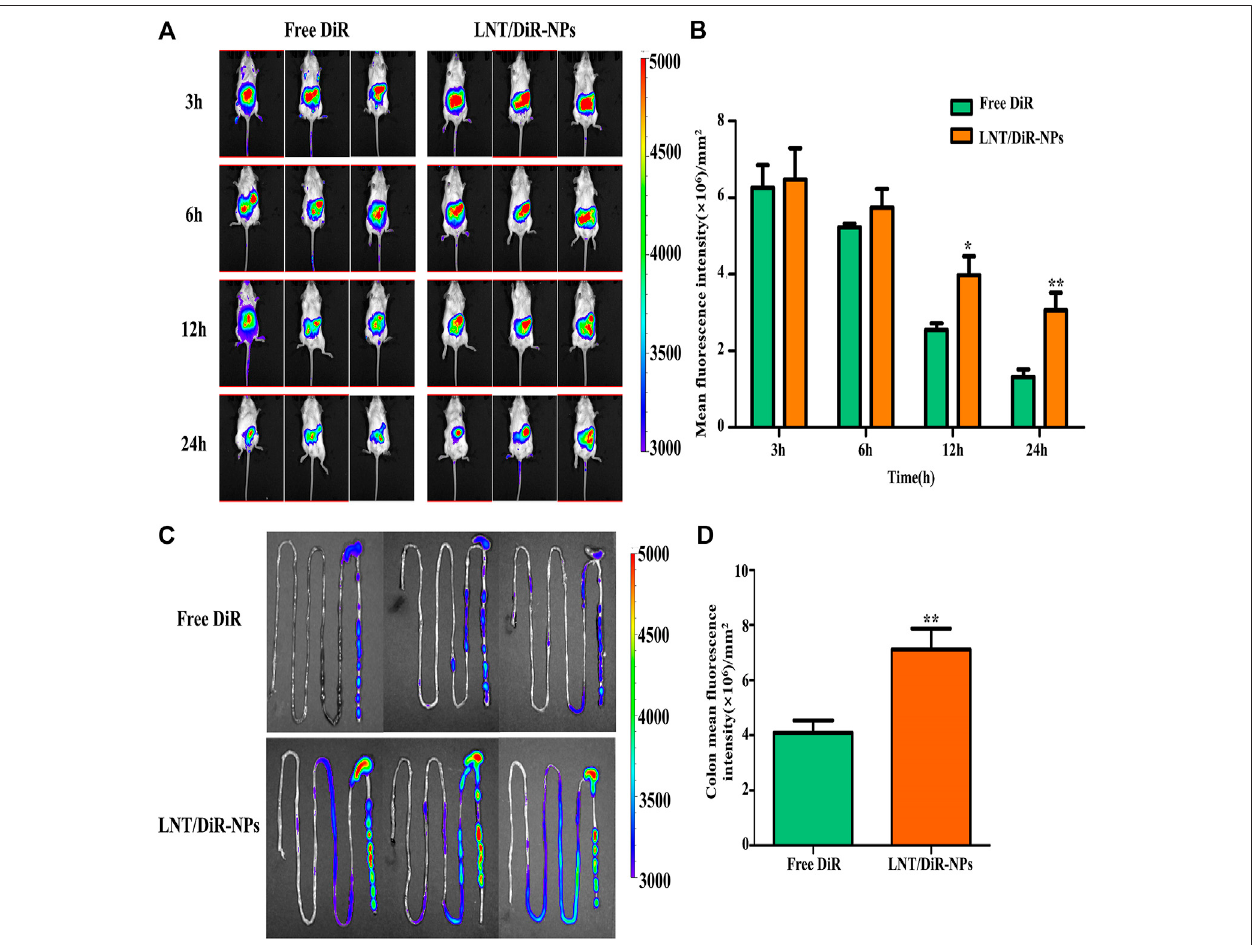
FIGURE 4| In vivo biodistribution evaluation of Free DiR and LNT/DiR-NPs to the DSS-induced UC mouse model. (A) Fluorescence imagesof mouse treated with FreeDiRandLNT/DiR-NPsatdifferenttimepoints(3,6,12,and24 h). (B) Histogramanalysisofmouse fl uorescencevaluesbetweenFreeDiRandLNT/DiR-NPstreated mouseatdifferenttimepoints. (C) FluorescenceimagesofmouseintestinebetweenFreeDiRandLNT/DiR-NPsat24 h. (D) Histogramanalysisofintestinal fl uorescence values between Free DiR and LNT/DiR-NPs at 24 h. * p < 0.05, ** p < 0.01 vs. Free DiR, n (cid:1) 6.